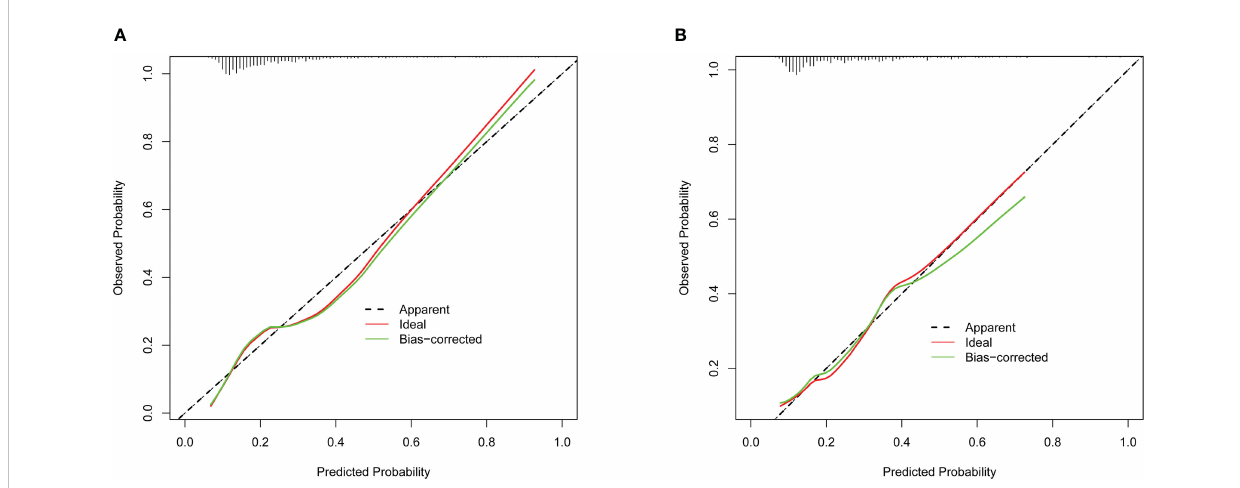
FIGURE 4 The calibration curve of POP risk nomogram. (A) Calibration curve in the training cohort (n = 877). (B) Calibration curve in the validation cohort (n =